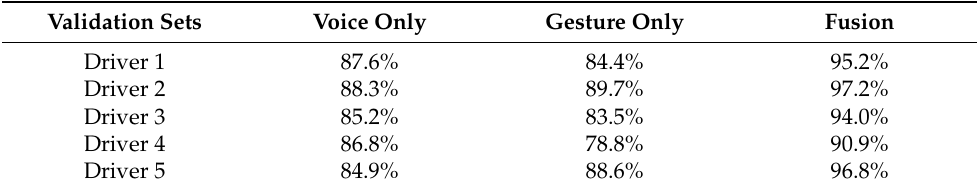
Table 6. Accuracies of HVI systems for each